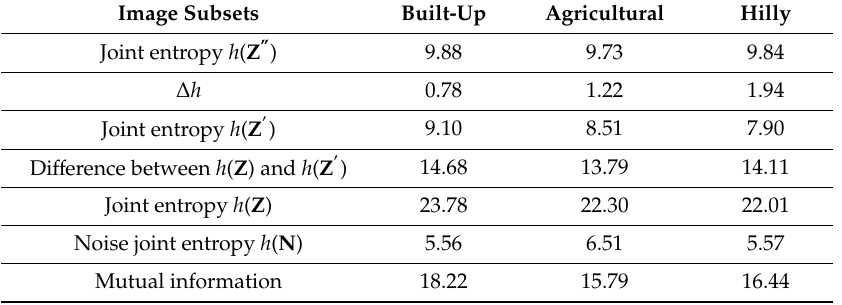
Table 5. Estimates of information content in original image subsets with spectral dependence, spatial dependence, and non-normality accommodated (bits / pixel).